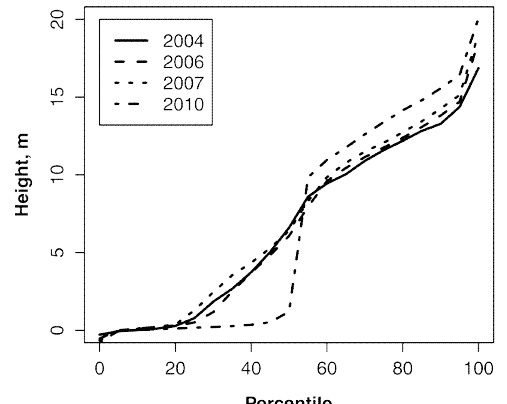
Fig. 6. Cumulative LiDAR h -distributions near plot A in an area that was cleared from dense understory in